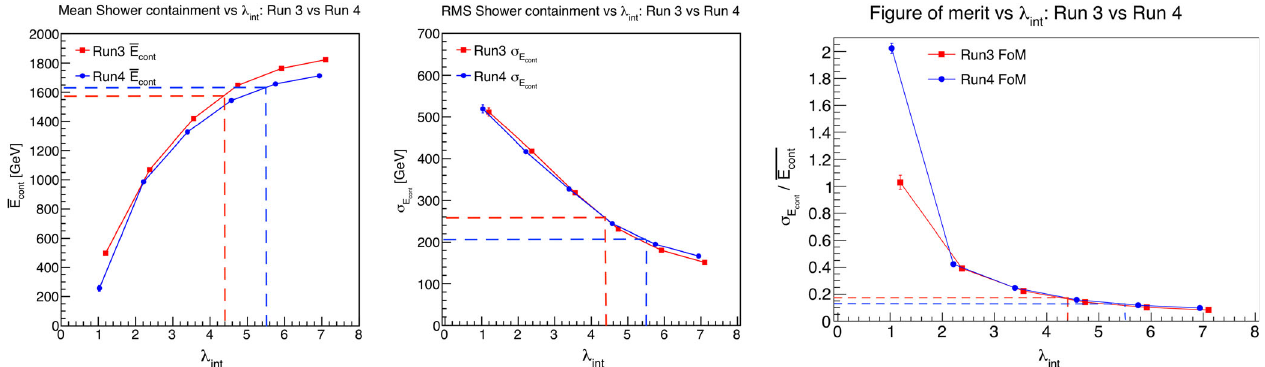
FIG. 14. HL ZDC performance evaluated via Geant4 MC. Comparison of run 3 and run 4 mean (left panel) and standard deviation (central panel) of the energy containment distribution for the ZDC for 2.5 TeV neutrons. Both the current detector and the HL ZDC were simulated with different interaction lengths to determine the detector ’ s performance as a function of the geometry. The ratio between the standard deviation and the mean of the energy containment is used to build the figure of merit of the detector (right panel). See Ref. [34] for more